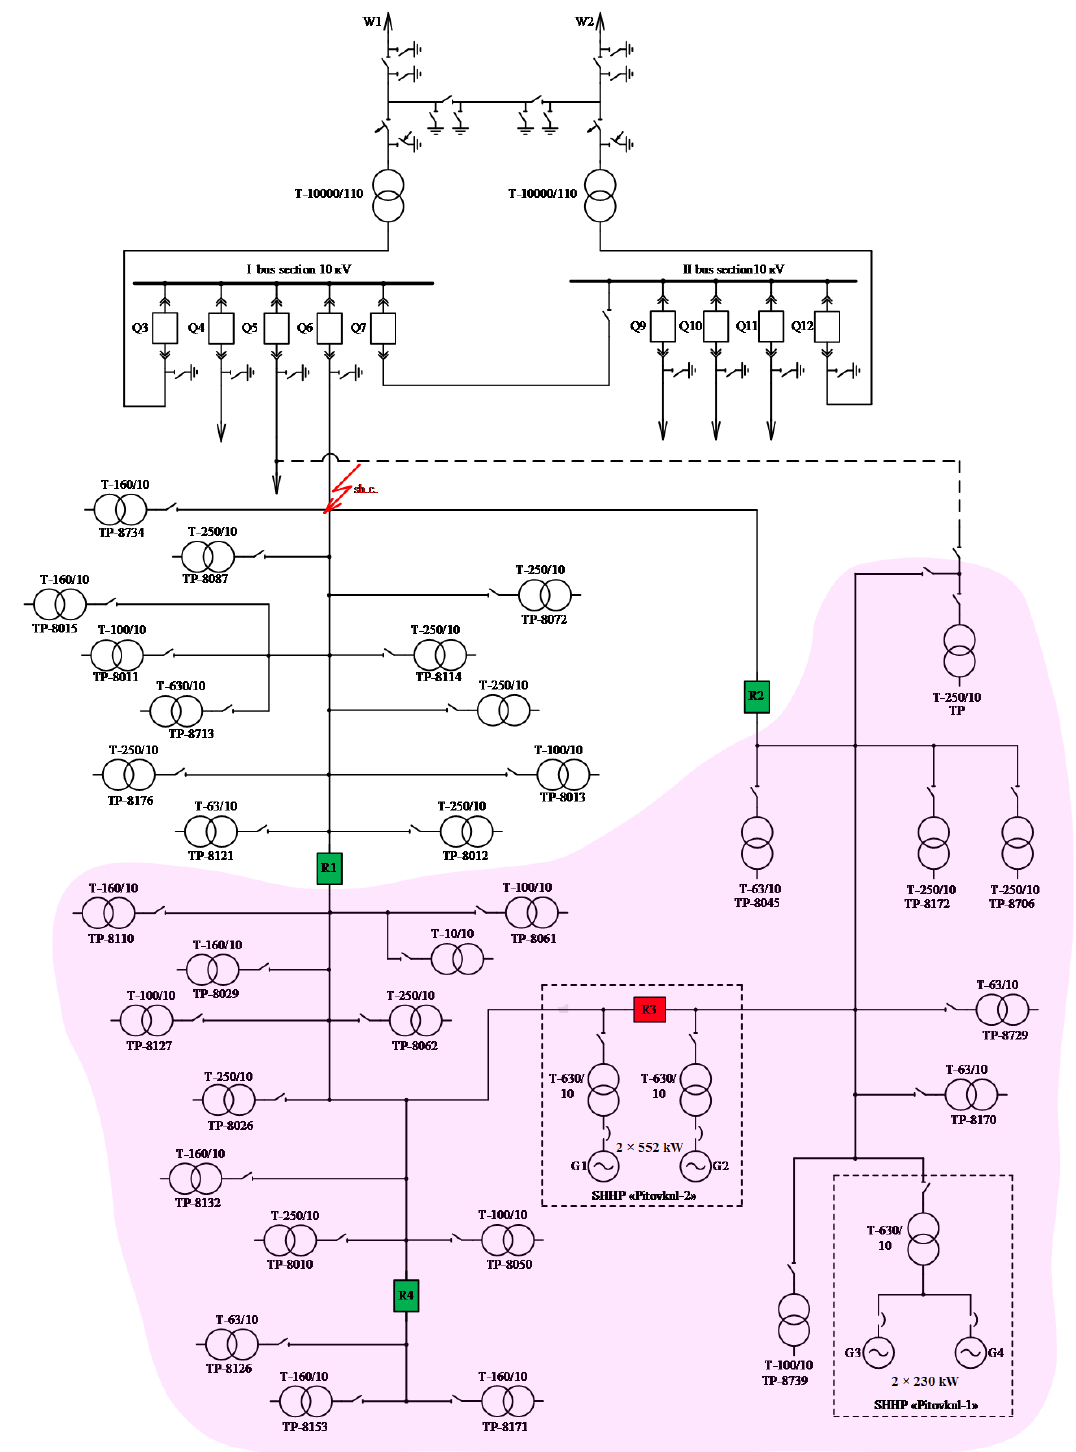
Figure 6. Model of the rural area grid of the Lahsh region of Tajikistan, Central Asia. Without those reclosers, generators of small hydropower plants would fall out of synchronism each time a disturbance occurs. An example of such an event is shown in Figure 7.